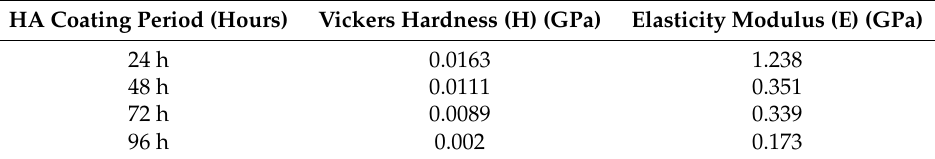
Table 6. Vickers hardness of HA coating surfaces and the changes in elasticity modulus by different holding periods in SBF [12].